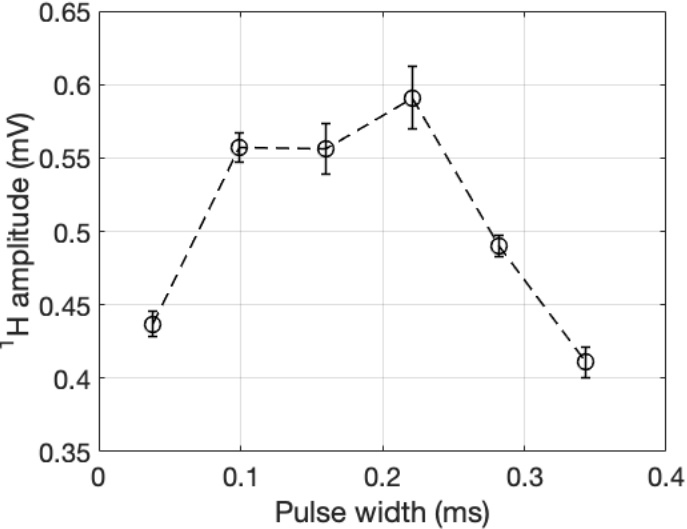
Figure A5. 1 H amplitude vs pulse width for a pulse amplitude of 2.4 V, at 32.8 kHz. Dashed lines are to guide the eye